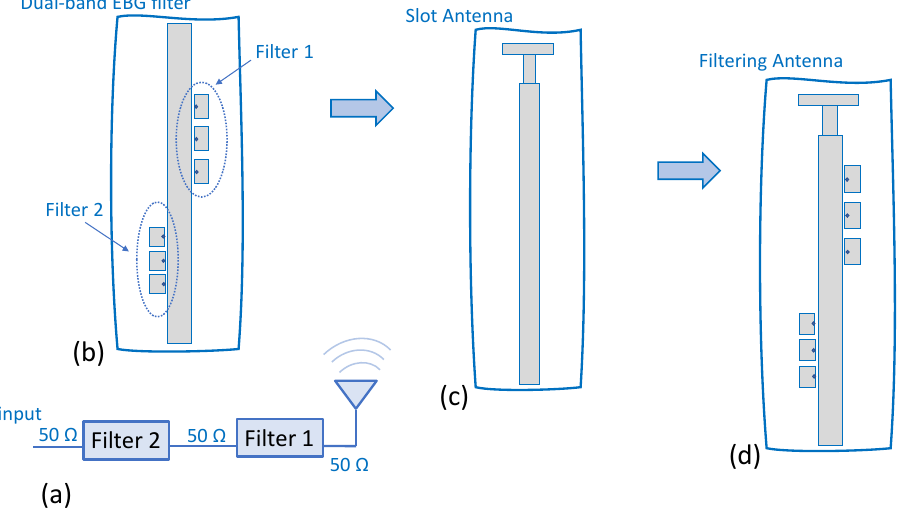
Figure 2. Description of the IM-GWG cascaded two filters and slot antenna. ( a ) Schematic. ( b ) Dual- band EBG filter. ( c ) Slot antenna. ( d ) Filtering